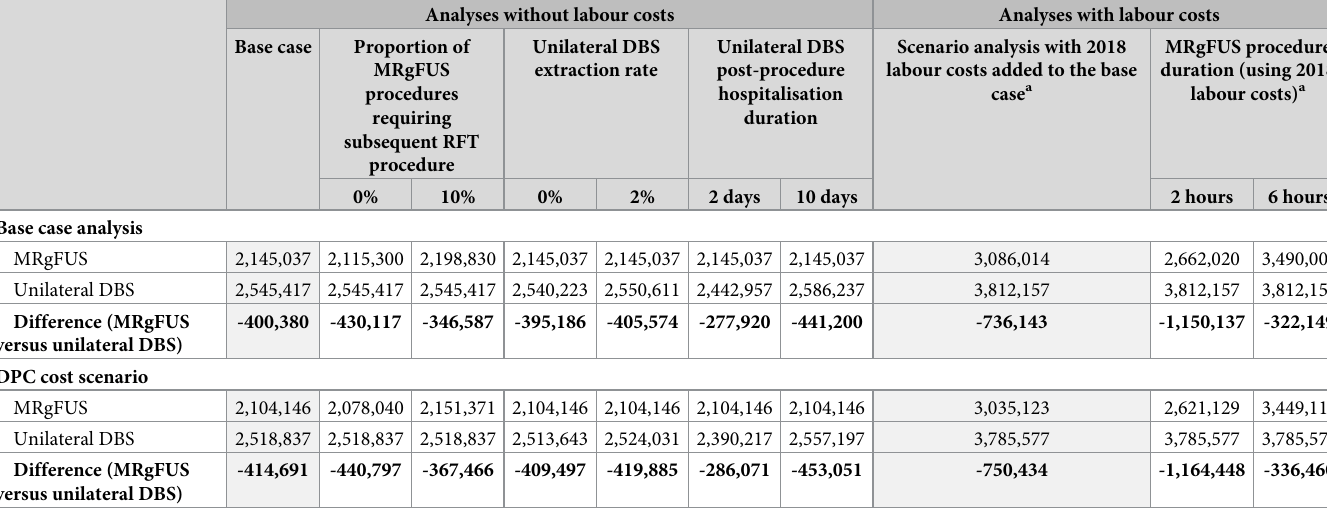
Table 4. Overall costs per procedure for MRgFUS and unilateral DBS (sensitivity